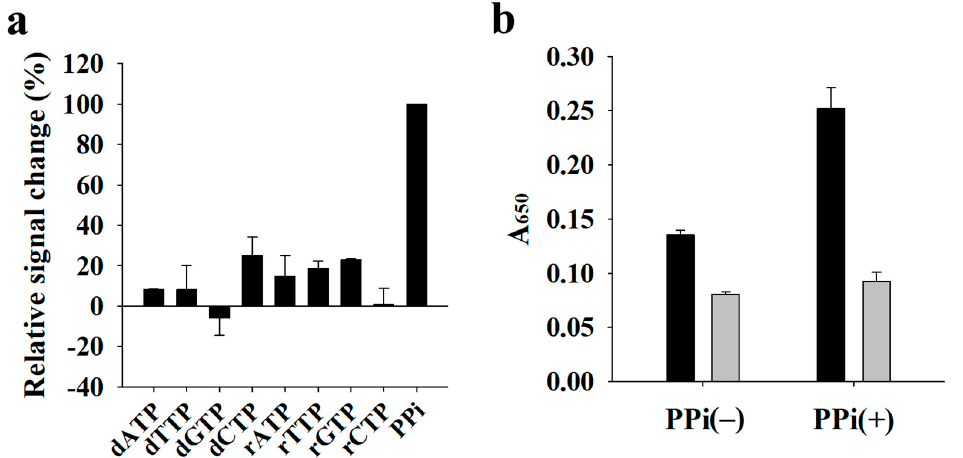
Figure 2. Selection of the best enhancer for CeO 2 NPs oxidase activity. ( a ) Relative signal change (%) of dNTPs (0.4 mM), rNTPs (0.4 mM), and PPi (0.4 mM). Relative signal change (%) was calculated as the DNA-induced signal change in the presence of dNTPs and rNTPs divided by that in the presence of PPi and multiplied by 100 (%). ( b ) Absorbance signal at 650 nm (A 650 ) in the absence ( − ) and presence (+) of PPi (0.4 mM). Black and gray bars indicate the absence and presence of synthetic DNA, respectively.